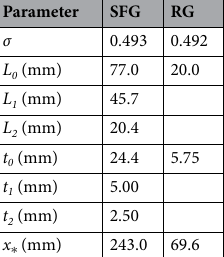
Table 1. Geometrical parameters of SFG and